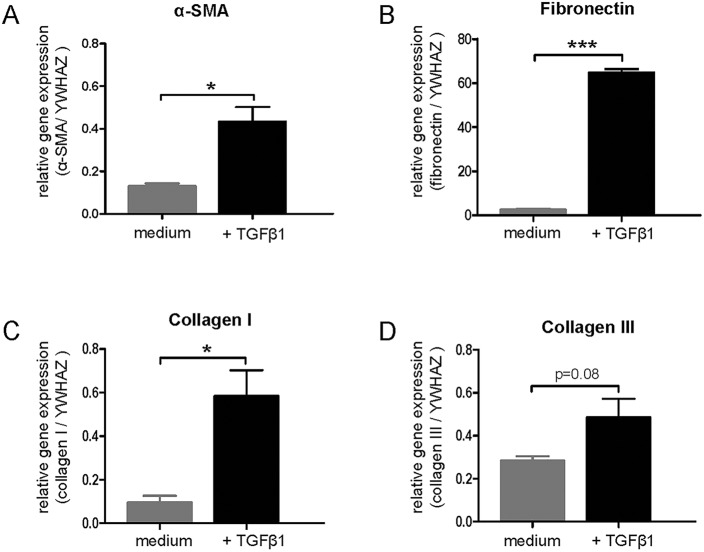
TGFβ1 (5 ng/ml) induces expression of fibrotic markers in mPCKS. mRNA expression of (A) α-SMA, (B) fibronectin, (C) collagen I and (D) collagen III in mouse kidney slices after 48 h of incubation. *P<0.05, ***P<0.001 versus medium.